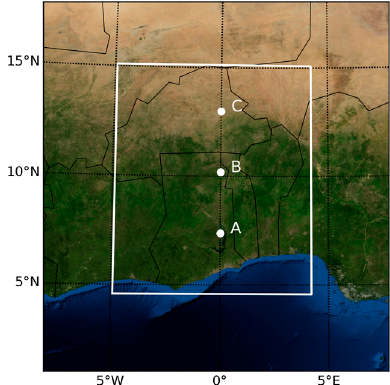
Figure 1. Study Area “Burkina Faso, Ghana and Benin” (4.92° W–4.22° E, 4.56° N–15.08° N) and three grid points for the evaluation, each representative for Guinea Coast— A (7.37° N, 0.00° E), Sudan— B (10.18° N, 0.00° E) and Sahel— C (12.98° N, 0.00° W).